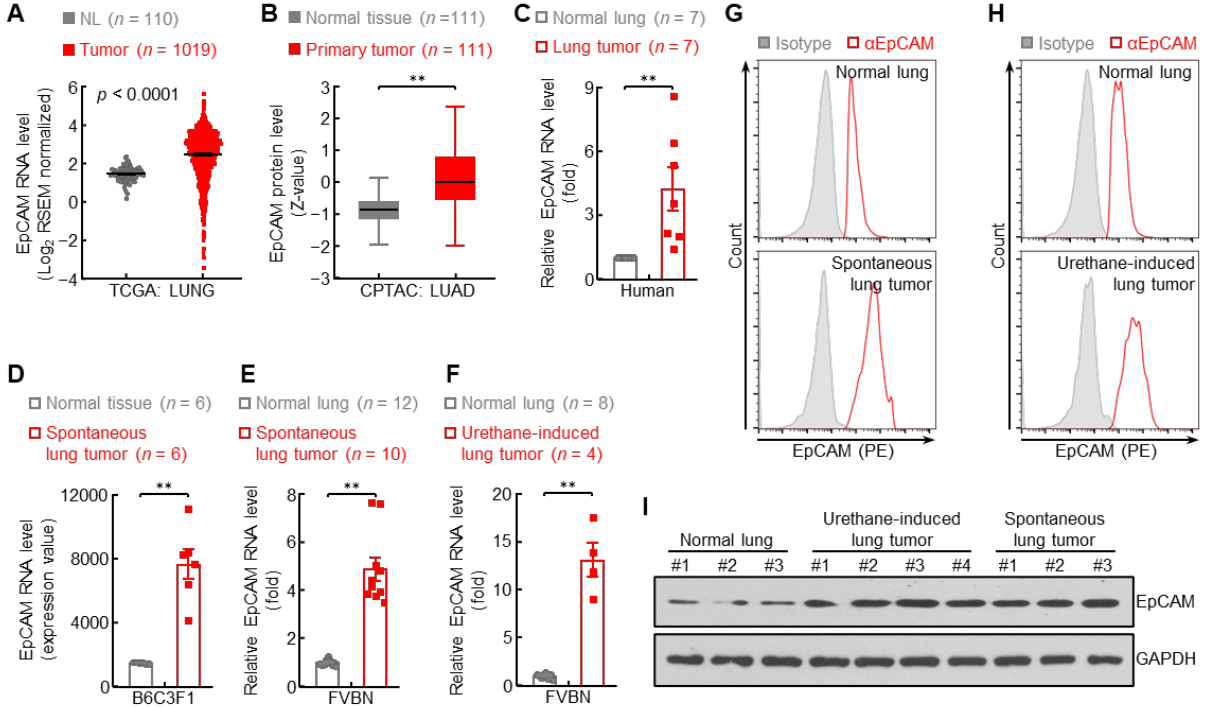
Figure 1. EpCAM expression is upregulated in primary lung cancer. ( A ) TCGA LUNG data showing increased EpCAM RNA expression in human primary lung tumor (Tumor: red dot) compared to normal lung (NL: grey dot). ( B ) CPTAC LUAD data showing increased EpCAM protein expression in human primary lung tumor. ( C ) qPCR data showing increased EpCAM RNA expression in human primary lung tumor compared to normal lung tissue from the same patients. ( D ) GSE31013 data showing increased EpCAM RNA expression in spontaneous primary lung tumor from B6C3F1 mice. ( E , F ) qPCR data showing increased EpCAM RNA expression in spontaneous ( E ) and urethane-induced ( F ) primary lung tumor from FVBN mice. ( G , H ) FACS data showing increased EpCAM protein expression in spontaneous ( G ) and urethane-induced ( H ) primary lung tumor from FVBN mice ( n = 4). ( I ) Western blot data showing increased EpCAM protein expression in urethane-induced and spontaneous primary lung tumor from FVBN mice. Date are representative of at least three independent experiments with similar results ( C , E – I ). Student’s t test (two-tailed, unpaired) was performed. Data represent means ± SEM ( A , C – F ) and means ± SD ( B ). ** p < 0.01.